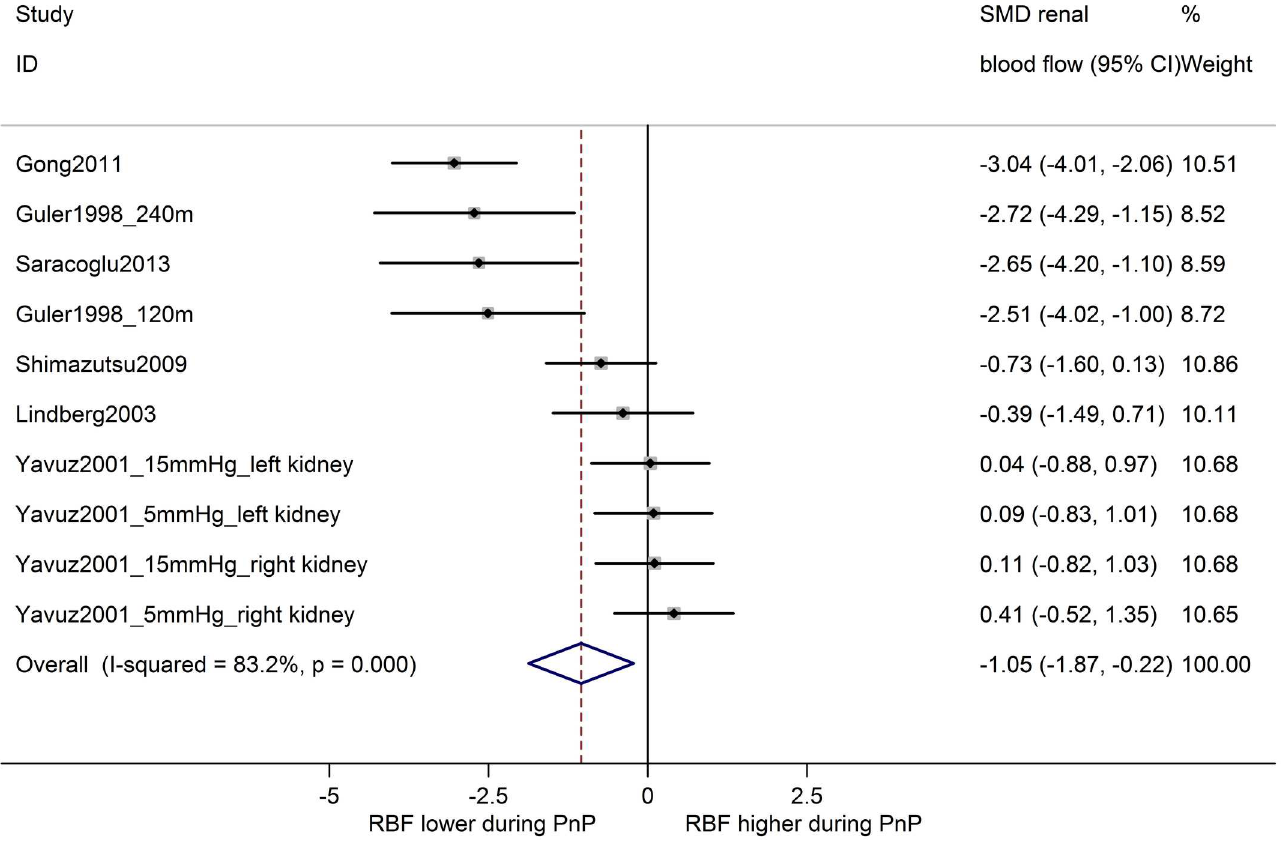
Fig 6. Renal blood flow is decreasedduring pneumoperitoneum compared to controls. Forest plot of studies comparingrenal blood flow in animals undergoing pneumoperitoneumwith control animals. Effect size is calculated as standardized mean difference (SMD) in renal blood flow, and corresponding 95% confidence intervals (95%CI). Weights are from random effects analysis. m = duration in minutes of PnP at time of measurement; mmHg = pressure in experimental group.